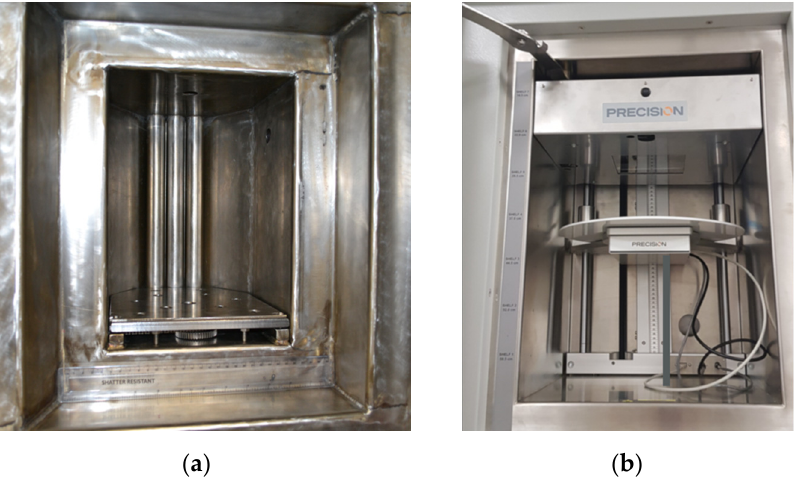
Figure 1. Irradiation chambers of equipment that supply ionizing photons. ( a ) The irradiation chamber of the 60 Co gamma irradiator, measuring 20 cm wide by 25 cm deep by 27 cm high. The guide rods for the sources can be seen at the back of the chamber. One 19 mm rod is visible in the top of the chamber and another one is visible near the top of the left wall. ( b ) The X-ray irradiator sample chamber, measuring 41 cm wide by 88 cm deep and 58 cm high. The X-rays are applied from above so that the radiation spreads out into a cone travelling downwards. One sample port is located on the back wall in the bottom right of the image.